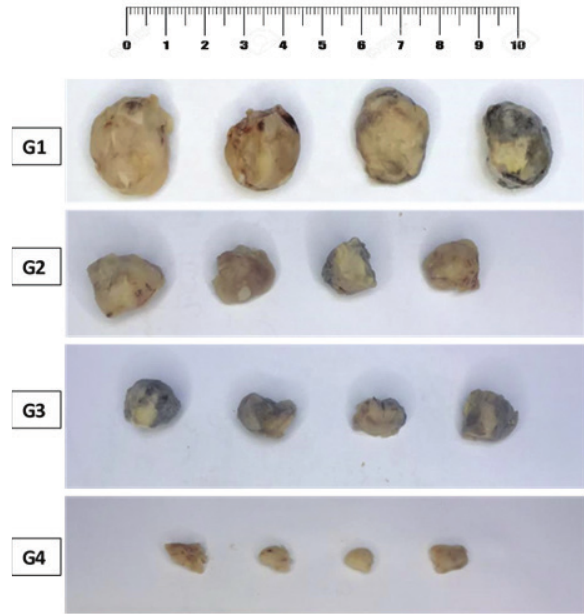
Figure 4 . The excised tumors at the experimental end with dif- ferent formulations, normal saline (G1), CBL solution (G2), non-targeted (G3), and targeted (G4)